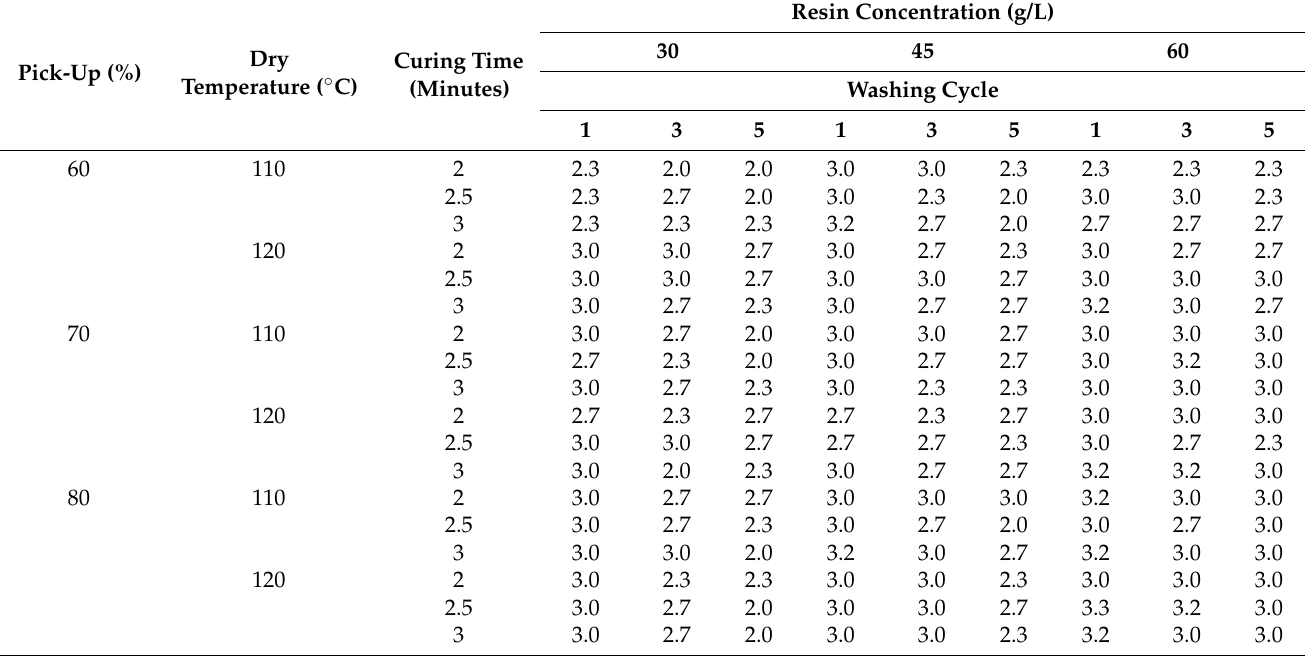
Table 4. Smoothness of fabric appearance grading (Grade 5 is the best while 1 is the